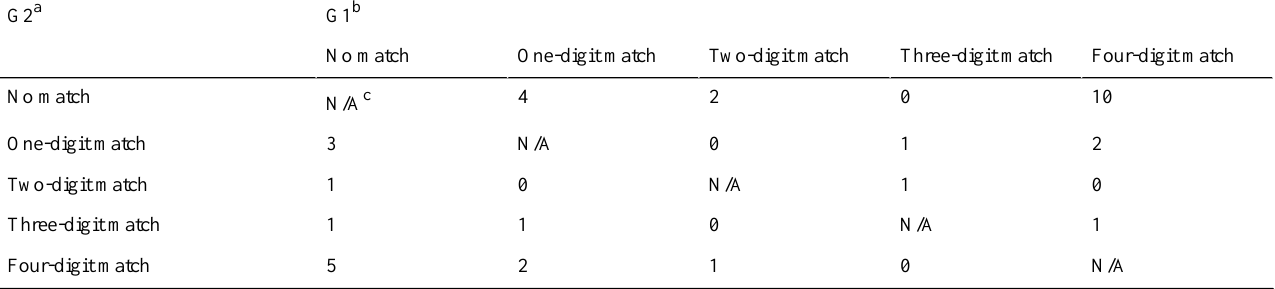
Table 7. Performance of Generation 2 compared with Generation